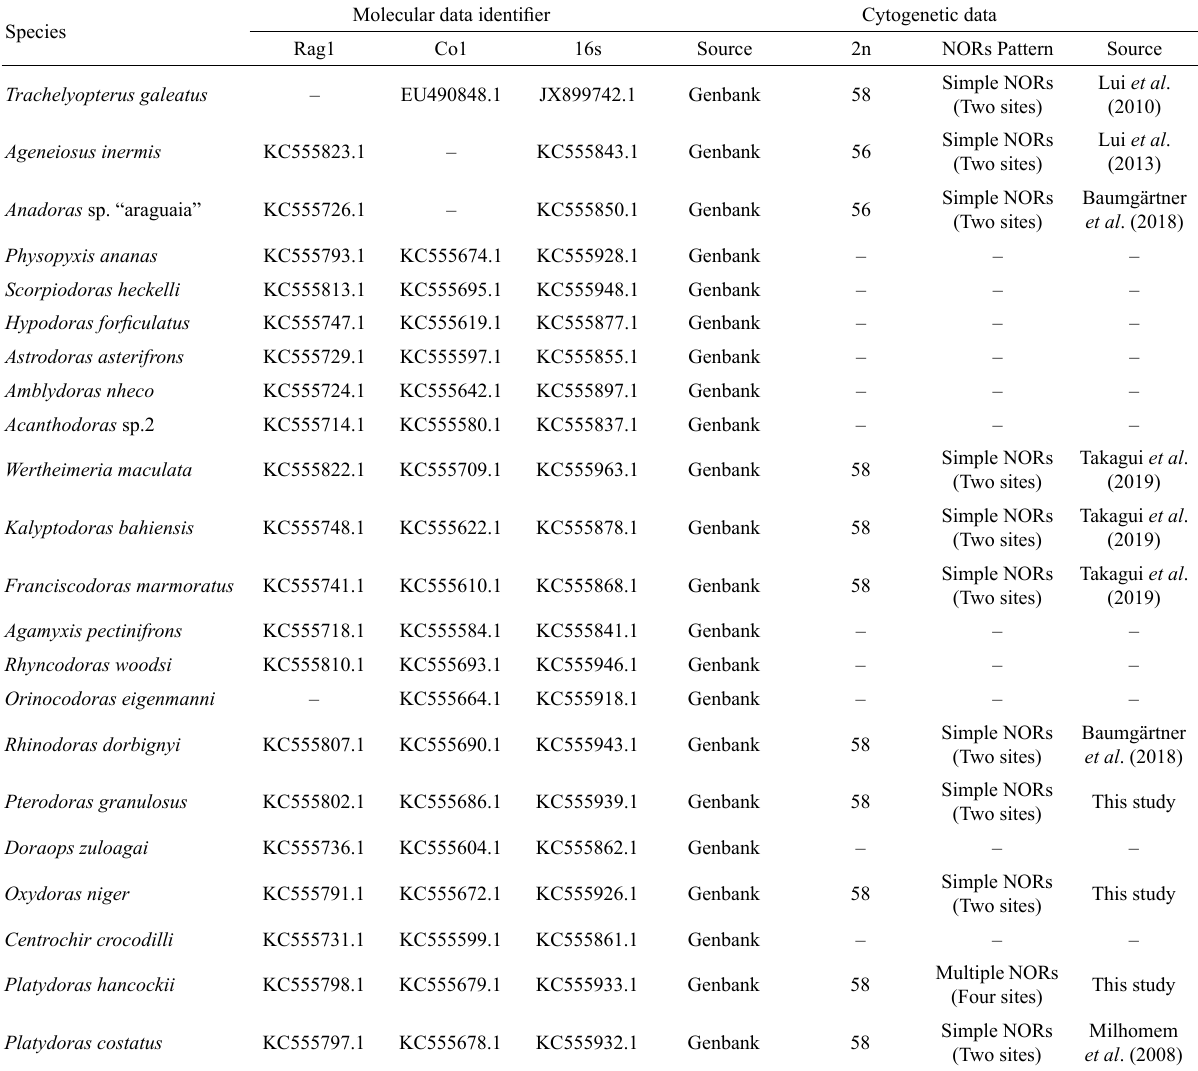
Table 3 – Molecular (GenBank access numbers of genes used in the phylogenetic reconstruction) and cytogenetic data (diploid number and NOR pattern) used by the Mesquite software to estimate the ancestral diploid number and NORs pattern for Doradidae. Legend: Rag1= recombination activating gene 1; Co1= cytochrome c oxidase subunit 1; 16S= ribosomal RNA 16S; 2n= diploid number; NOR= nucleolar organizator